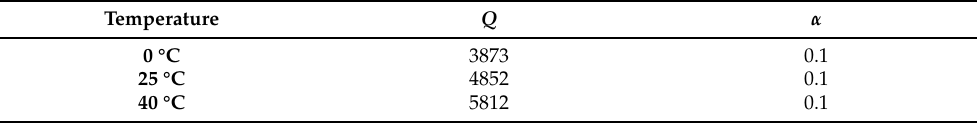
Table A16. Q and α models